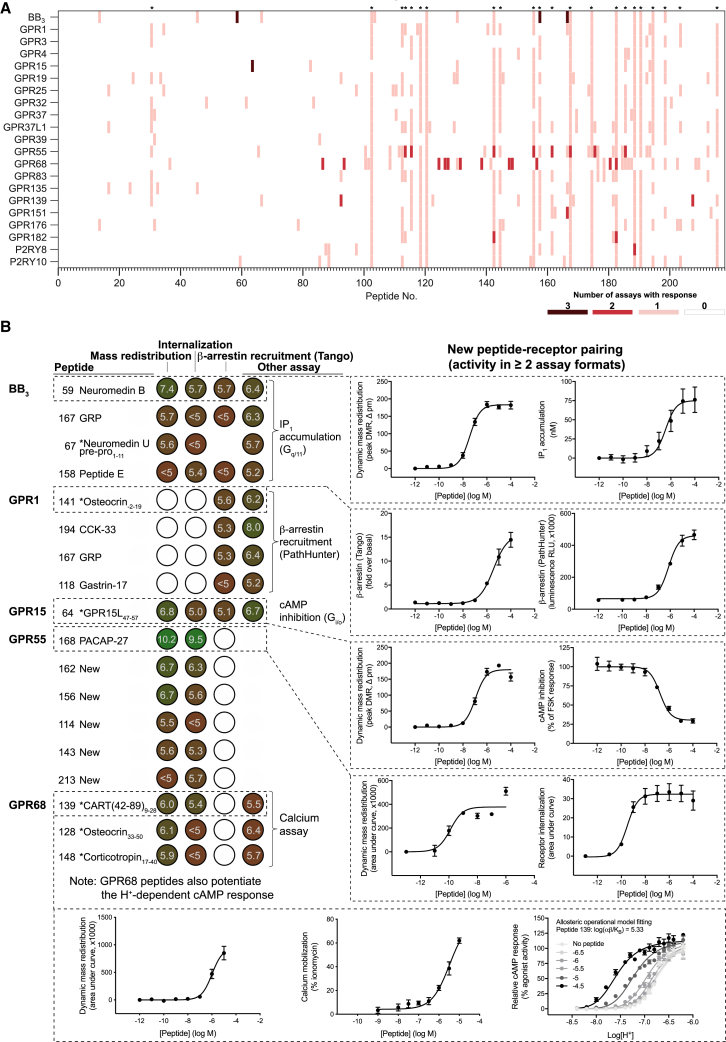
General versus Assay-Specific Responses and Novel Peptide-Receptor Pairings(A) The multifaceted screen of 218 peptides identified a variety of multiple and single-assay responses, including hits for all 21 predicted peptide receptors. Mass redistribution data revealed repeat hitters (denoted with asterisks) that reflect peptide-dependent responses from endogenous targets. Screening results for additional class A orphan and peptide GPCRs are provided in Table S6.(B) Pairing of 17 peptides with five orphan receptors. Colored circles show pEC50 values and concentration-response curves the most potent ligand for each receptor. Other assays used were Gq/11 (IP1), Gs and Gi/o (cAMP), and β-arrestin recruitment (PathHunter). An asterisk indicates a new cleavage variant of a known GPCR peptide ligand with the amino acid range of the cleaved peptide shown in subscript; empty circles indicate inactivity.All data represent mean ± SEM for 3–4 independent experiments, each performed in triplicate. Table S7 provides all related data and data for indicative pairings (tested in a single assay) for GPR17, GPR161, GPR176, GPR183, and MAS1.